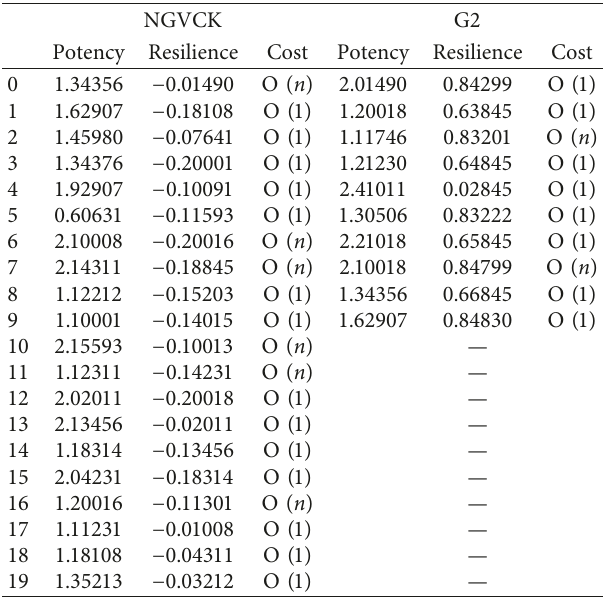
Table 1: Results of the proposed hybrid signal and encryption obfuscation (S&E) for different virus groups with potency, resil- ience, and cost metrics. NGVCK G2